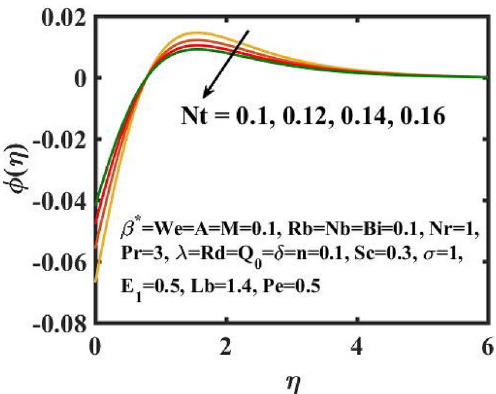
Figure 12. Encouragement of Nt on φ(η) .